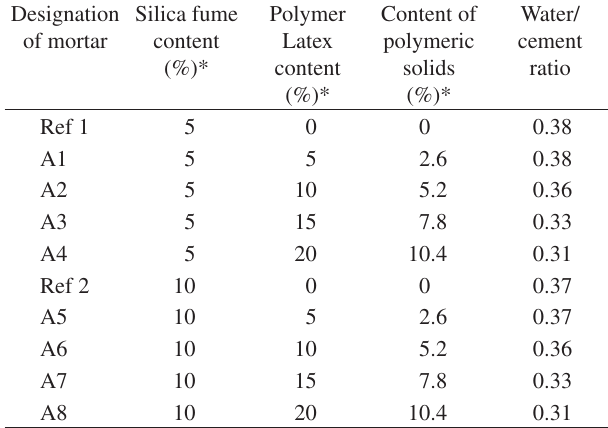
Table 3. Mix proportion of